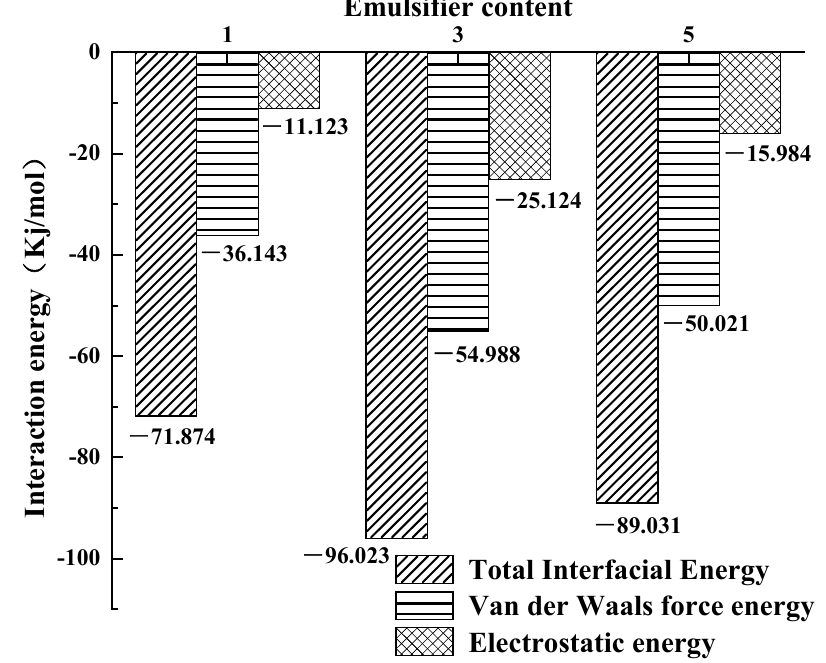
Figure 5. Interaction energy of asphalt/water emulsion with different emulsifier contents.